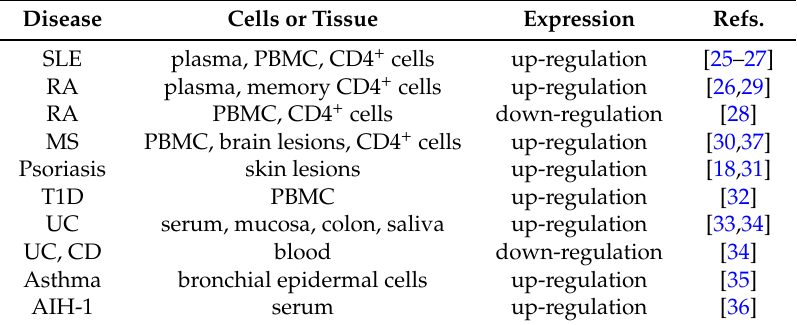
Table 3. miR-21 as a diagnostic biomarker for patients with autoimmune disease.